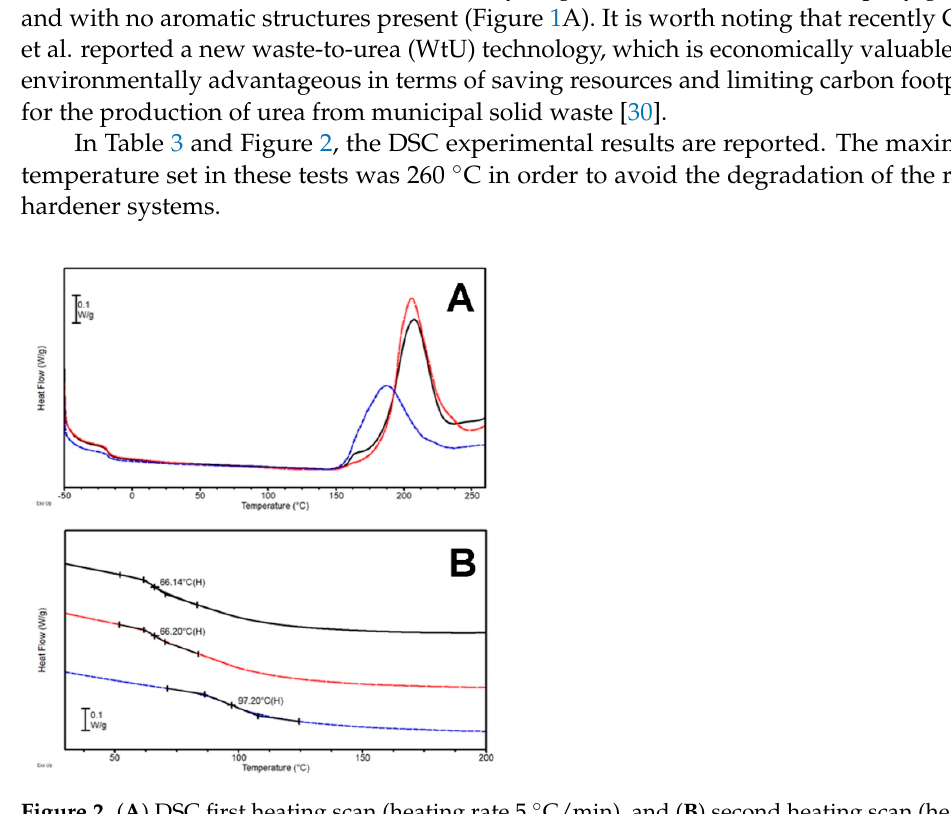
Table 3. Relevant DSC data of bio-based DTA, DTB, DTC and DTD samples.